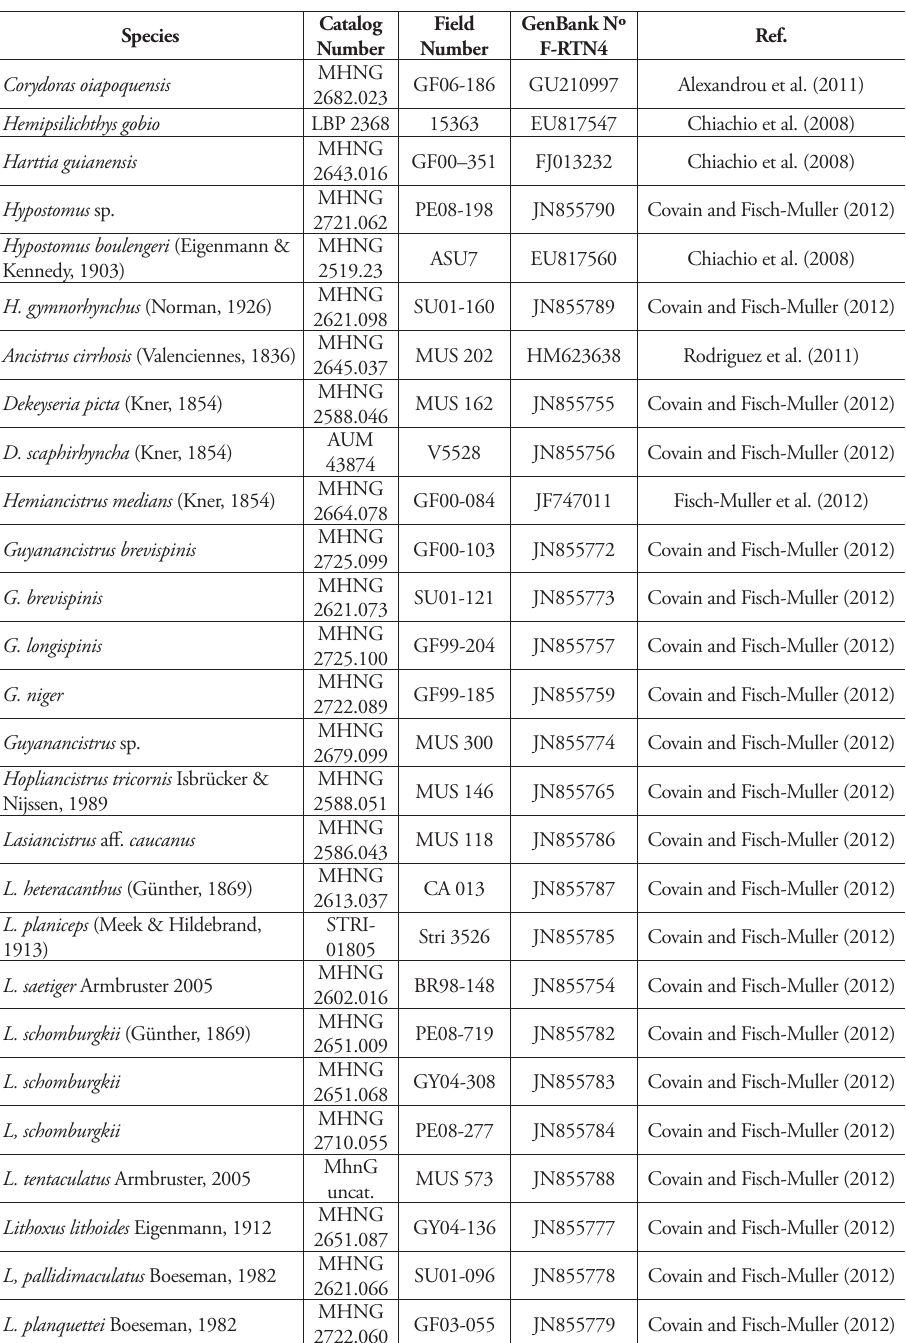
Table 3. Taxa list, specimen and sequence data analyzed in the present study (n=44). Institutional acro- nyms follow Fricke and Eschmeyer